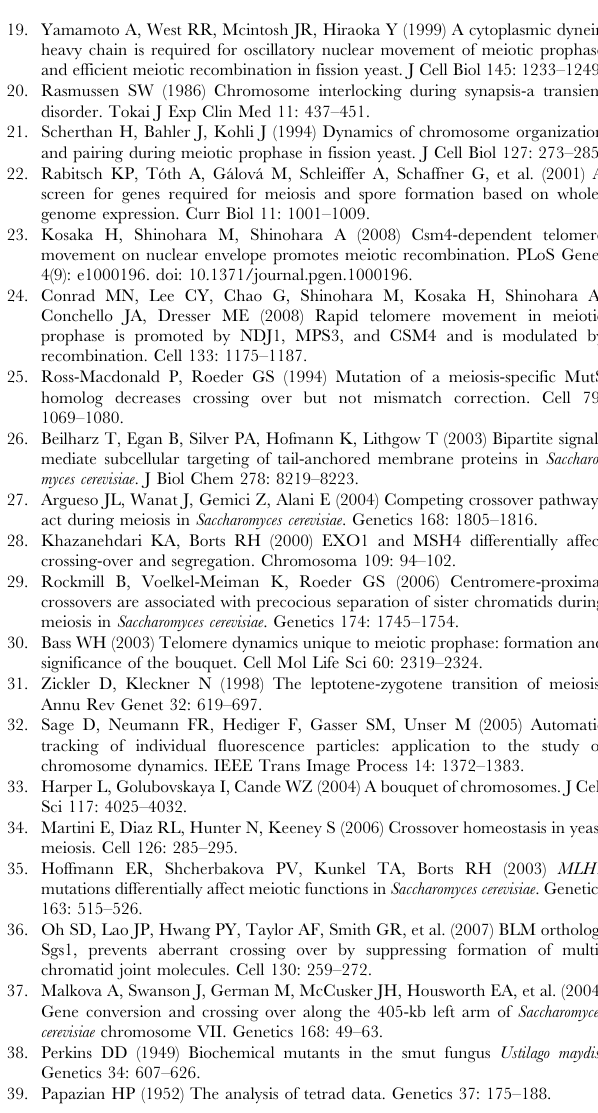
Table S4 Crossing over in WT tetrads, csm4 D tetrads, and csm4 D disomic